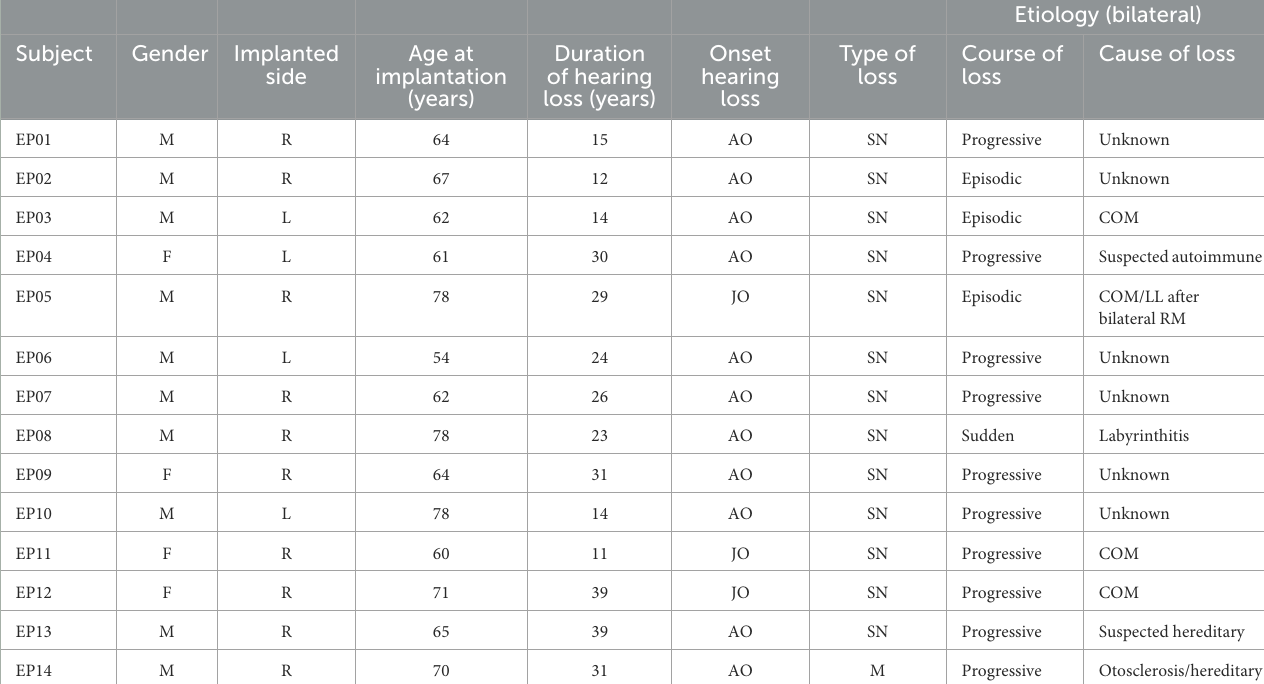
TABLE 1 Subject characteristics.